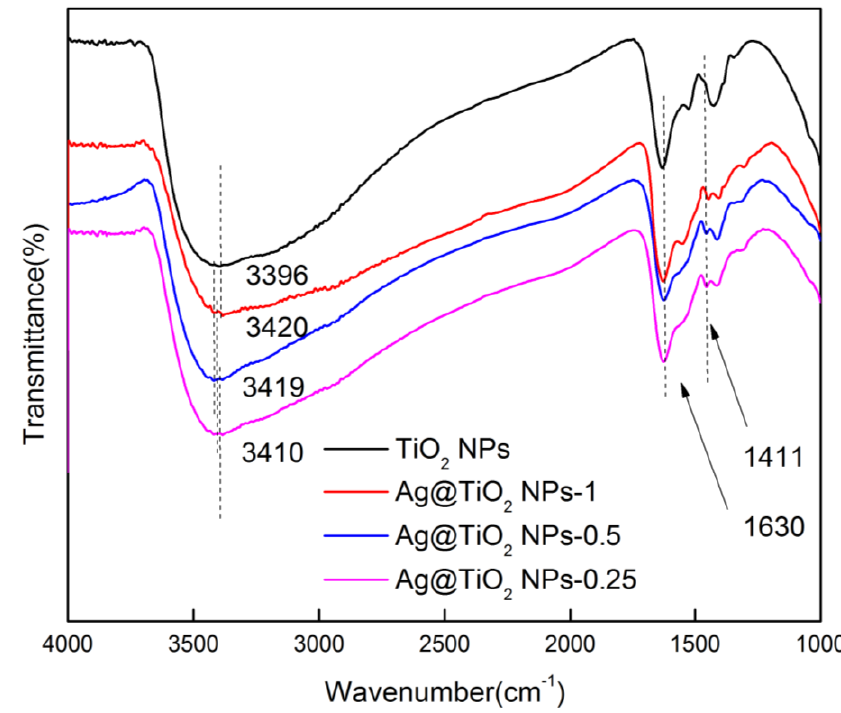
Figure 5. Fourier transform infrared spectra (FTIR) spectra of pure TiO 2 NPs and Ag@TiO 2 NPs.